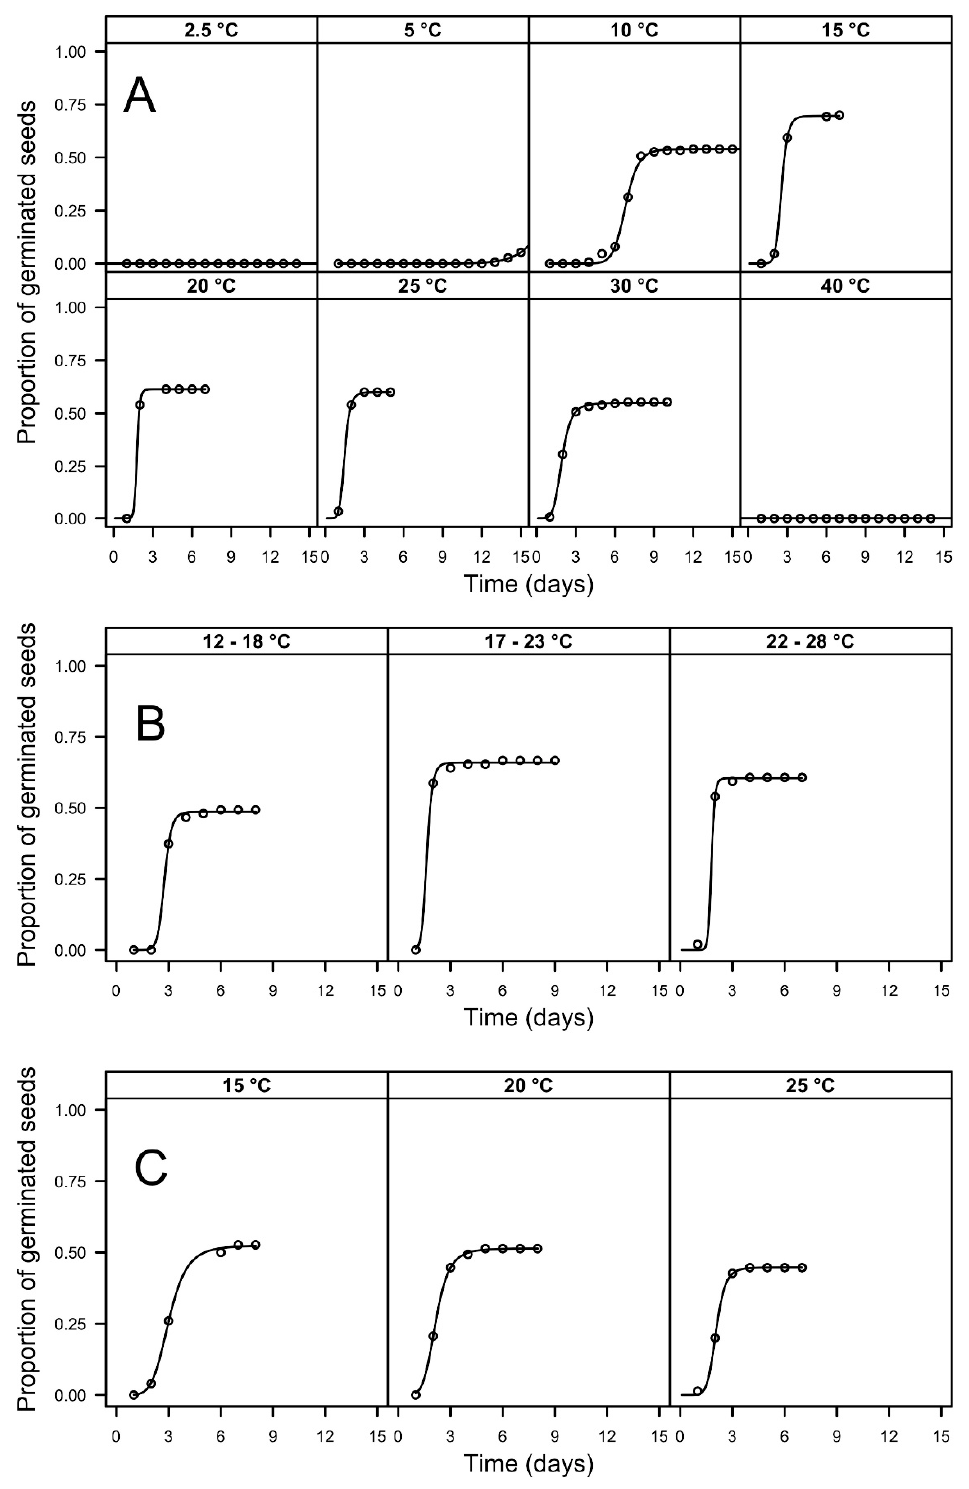
Figure 1. Germination time courses for Conyza canadensis , as observed at different temperature and light regimes: ( A ) = constant temperatures and light / darkness (12 h / 12 h) regime; ( B ) = alternating temperatures and light / darkness (12 h / 12 h) regime; ( C ) = constant temperatures and complete darkness. Symbols show the observed data, while lines show the fitted germination curves, according to Equation 1.